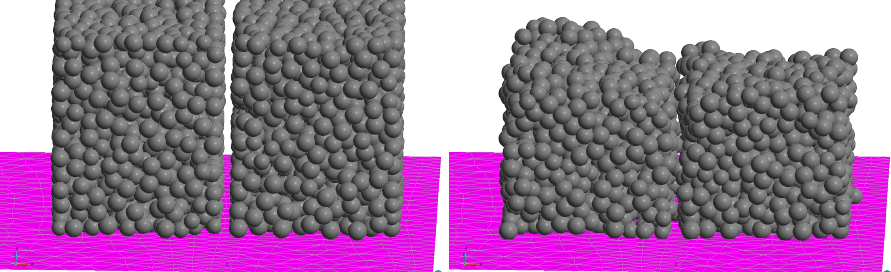
Figure 9. The effect of gravity on the initial shrinkage obtained in the DEM model. ( left ) initial state; ( right ) final state after 10 s of simulation time. The results of simulations are well